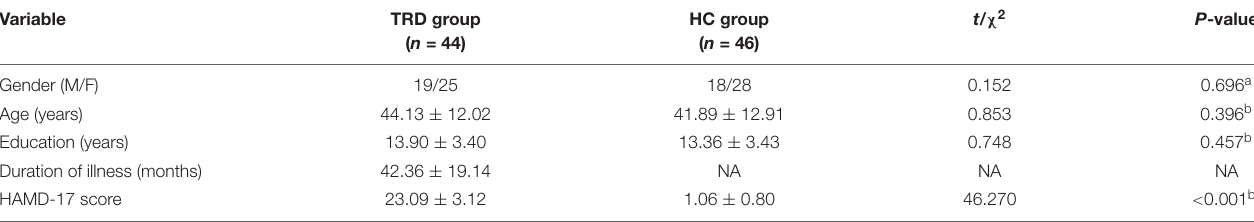
TABLE 1 | Demographic and clinical variables.